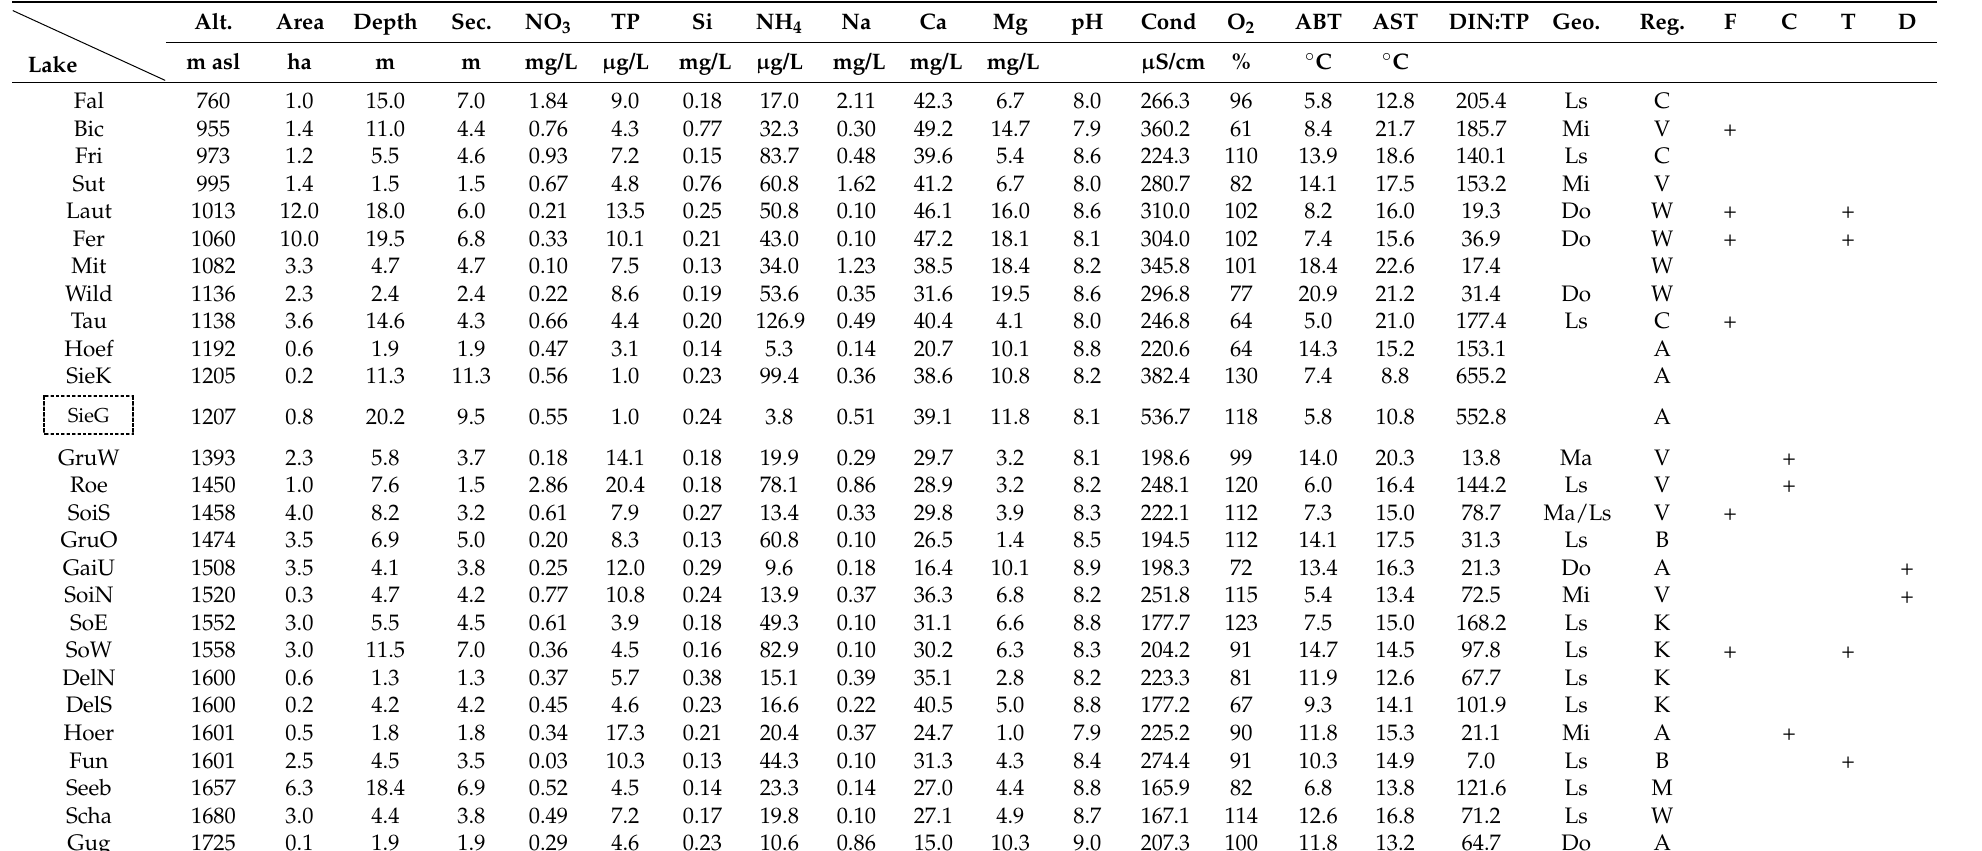
Table 1. Ecologically important morphological, physical, and chemical parameters were assessed for 43 mountain lakes in the northern European Alps ranging from 760 to 2469 m asl. The dashed box indicates an outlier lake that is strongly influenced by groundwater inflow. ABT = August bottom temperature, AST = August surface temperature. For abbreviations of other variables see Table S1. Abbreviations of the main bedrock type (“Geo.”): Ls = Limestone, Do = Dolomite, Ma = Marvel, Mi = Mixed. Abbreviations of the mountain regions (“Reg.”) are from west to east: A = Allgäu, L = Lechtaler Alpen, M = Mieminger Kette, W = Wettersteingebirge, K = Karwendel, R = Rofangebirge, V = Bayerische Voralpen, C = Chiemgauer Alpen, B = Berchtesgadener Alpen. Human impact is denoted by “+”: F = Fish stocked lakes, C = Intensive cattle herding, T = Nearby touristic infrastructure, D = Dammed lakes. Alt.